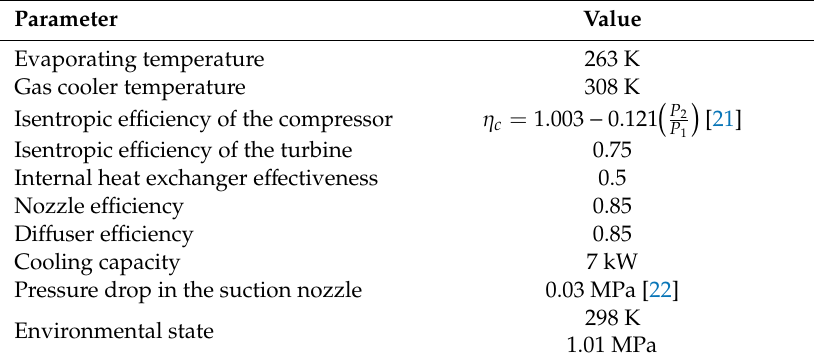
Table 1. Proposed operating conditions for the transcritical cycle in the simulation.